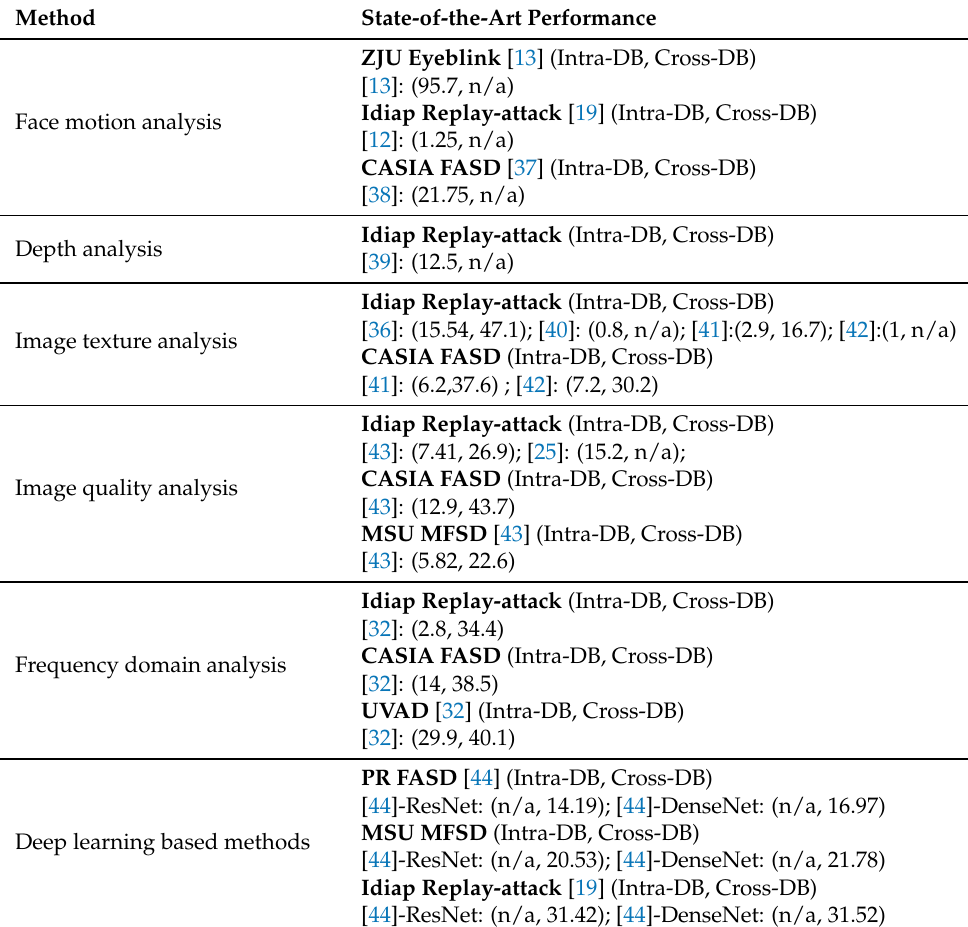
Table 1. Performance of published methods on face spoofing detection. Please refer to the text concerning the metrics used for